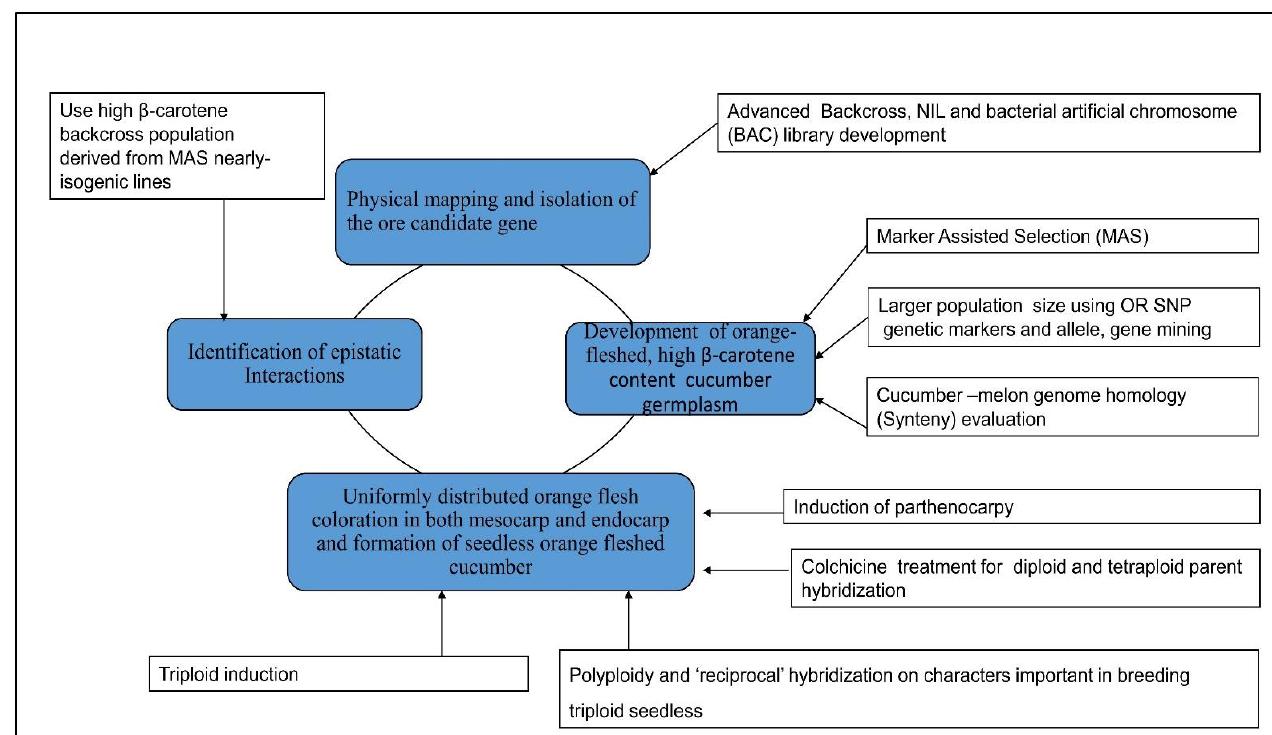
Figure 2. A summary of the proposed approaches to unravel the genetic basis of β -carotene accumulation in orange-/yellow-fleshed cucumber. The boxes highlighted in blue are the proposed main objectives, while the arrow points to the applicable methodology. Advanced backcross [21]; MAS [21,22,25]; OR SNP genetic markers [26]; Triploid induction [57]; cucumber-melon synteny [59,60]; parthenocarpy [61]; colchicine treatment [62]; polyploidy hybridization [63].